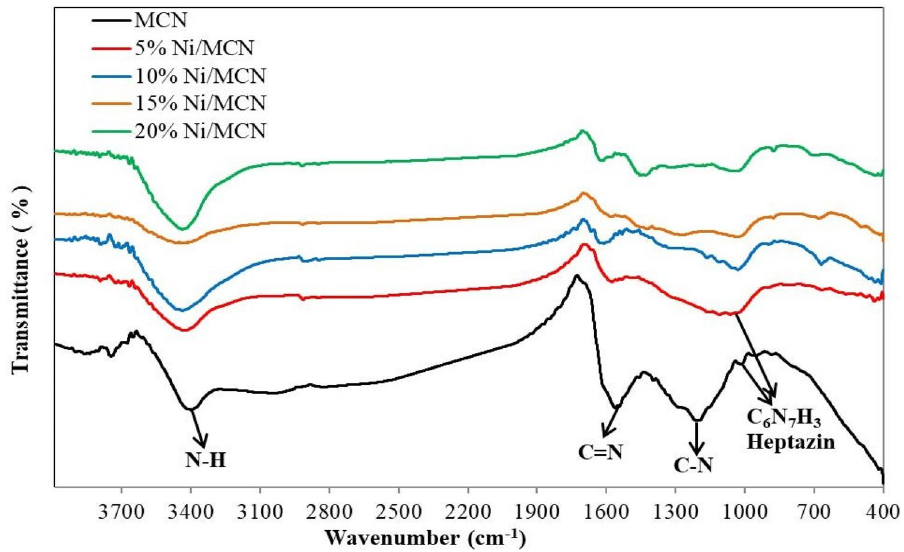
Figure 4. FT-IR of the prepared